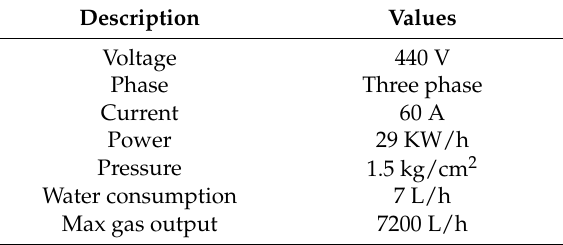
Table 2. The specifications of the HHO generator.